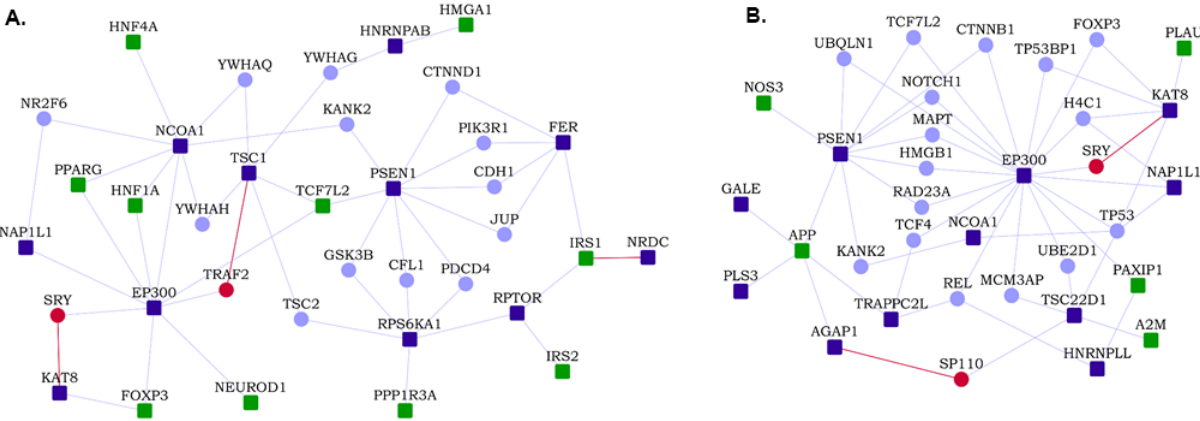
Figure 4. Diseases associated with the hypoplastic left heart syndrome (HLHS) interactome: The number of genes from the HLHS interactome that are involved in the top 10 ( A ) OMIM diseases and ( B ) DisGeNET diseases most significantly associated with the interactome are shown.